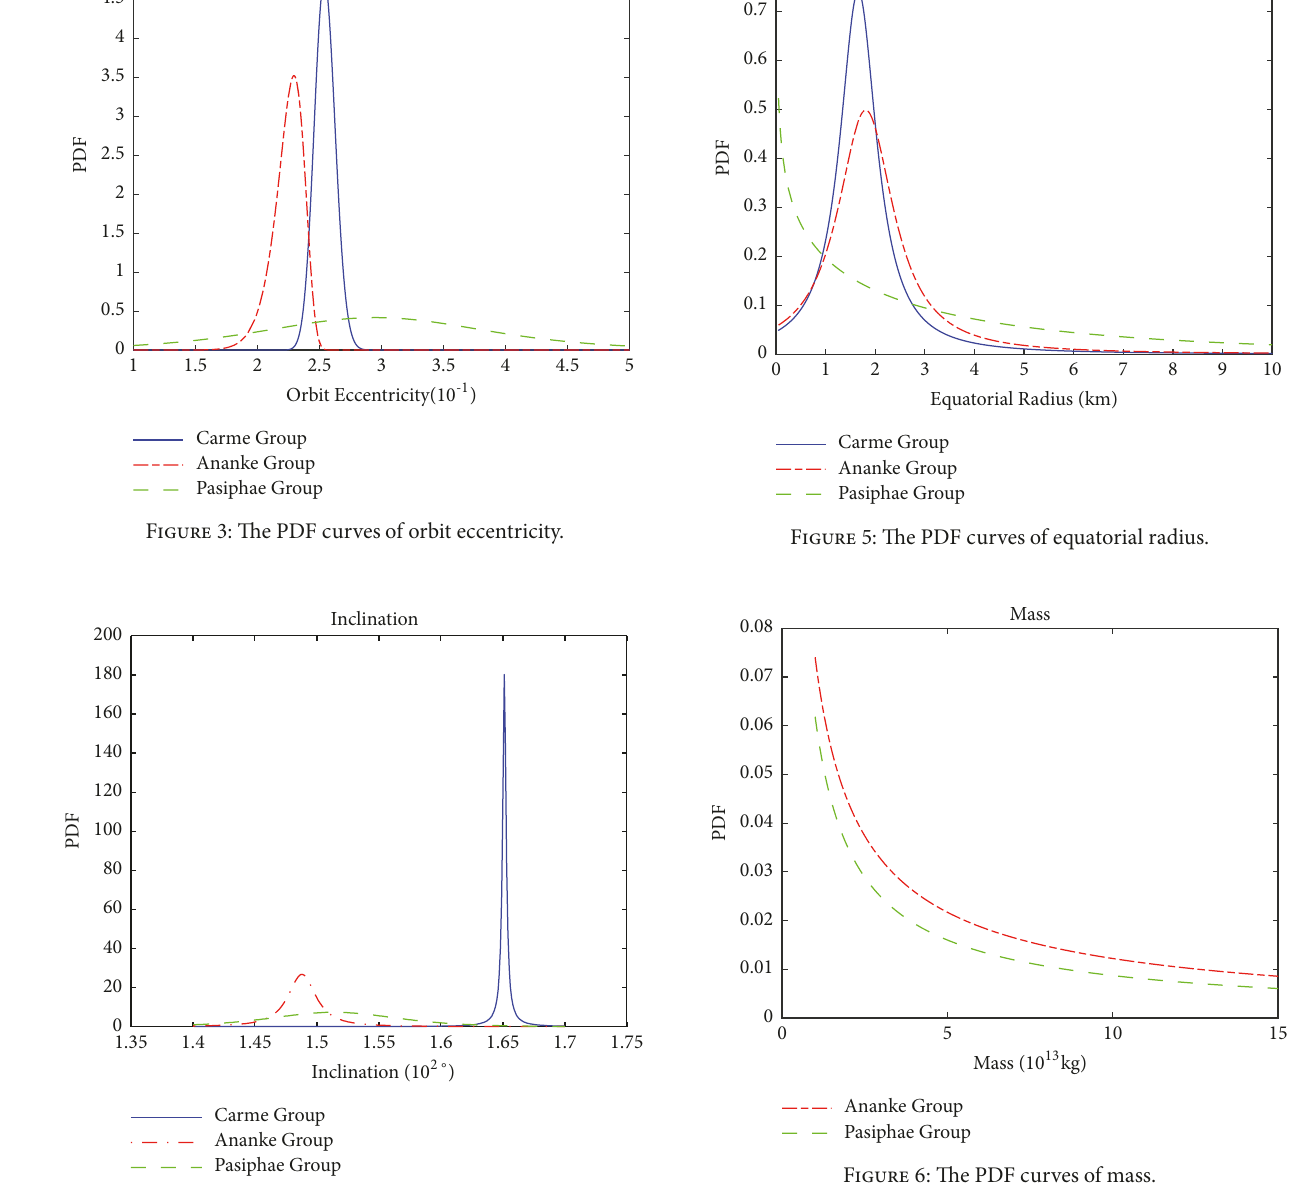
Figure 4: The PDF curves of inclination.